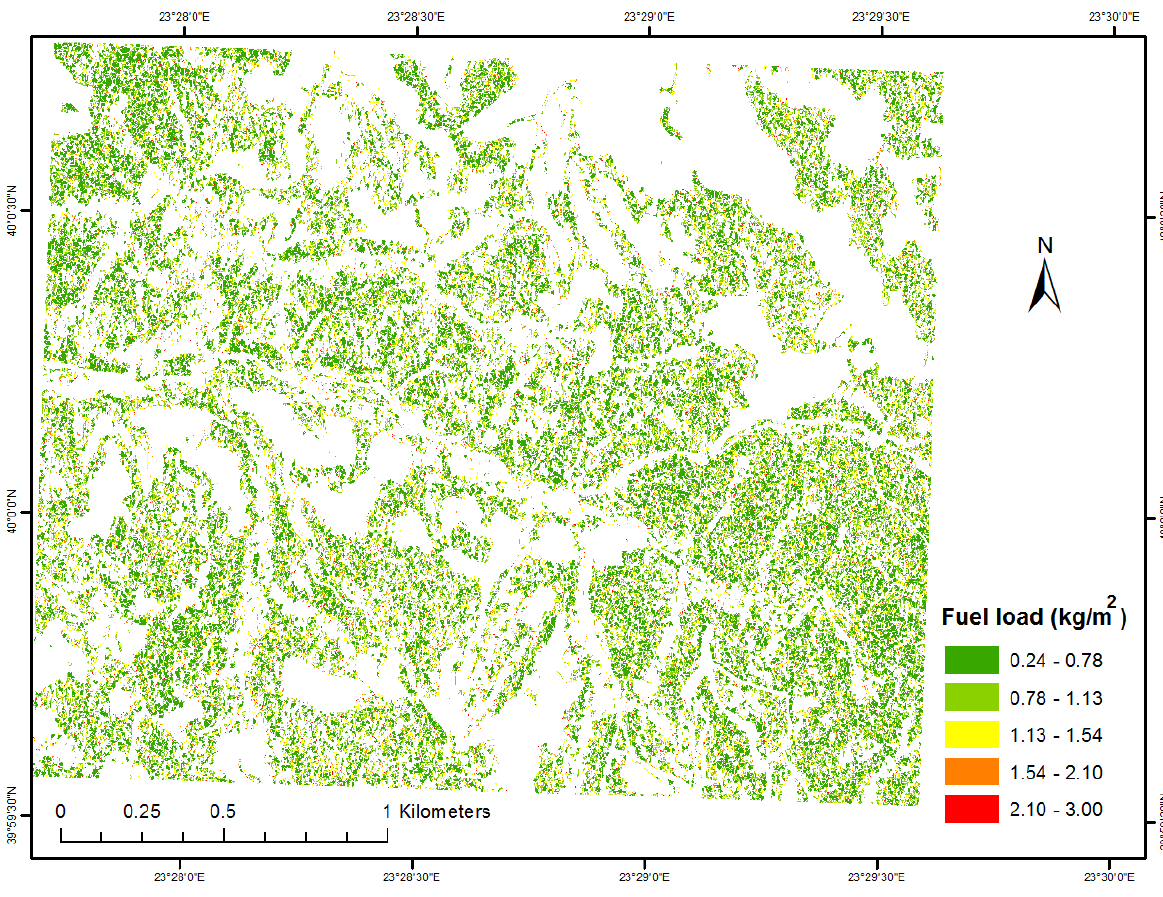
Figure 7. Canopy fuel load map for the Kassandra